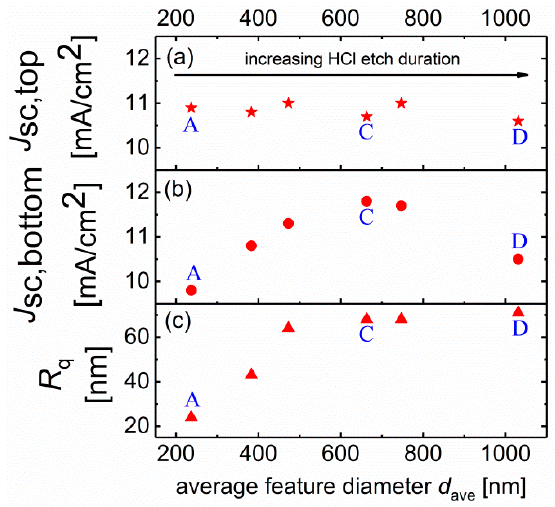
Figure 3. Short-circuit current density calculated from external quantum efficiency measurements of ( a ) top cell Jsc, top, ( b ) bottom cell Jsc, bottom and ( c ) rms-roughness Rq as a function of the average feature diameter of textured ZnO:Al surface for test series 1. The samples ‘A’, ‘C’, and ‘D’ are further discussed in Section 3.2.